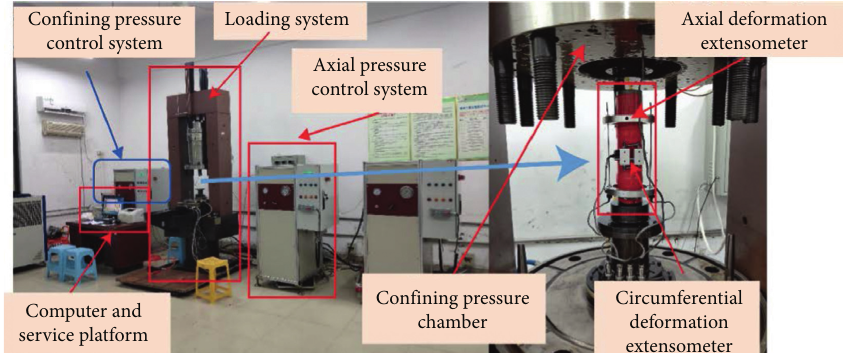
Figure 3: Installation of the TFD-2000 microcomputer servo-controlled triaxial rheological testing machine for rock and deformation extensometer.